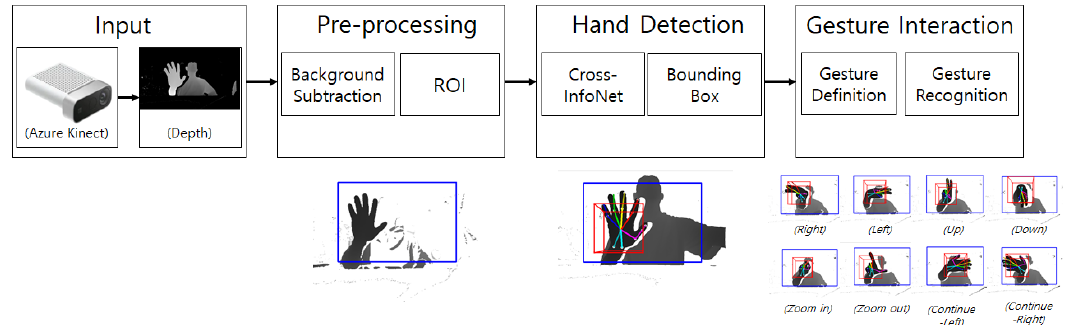
Figure 5. Framework of the hand gesture recognition system based on depth frames.